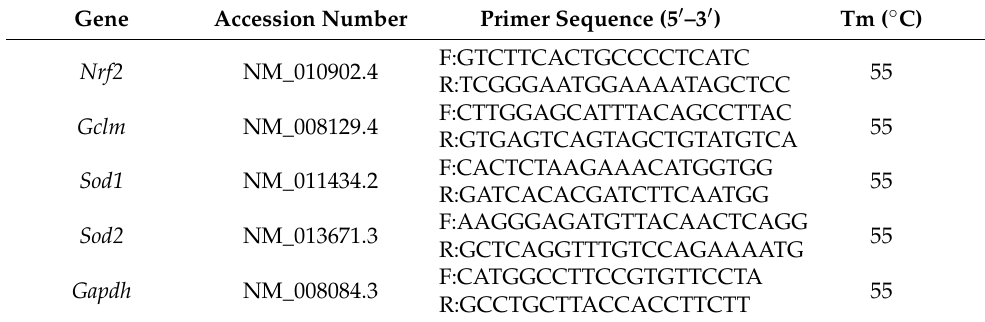
Table 1. Primers for